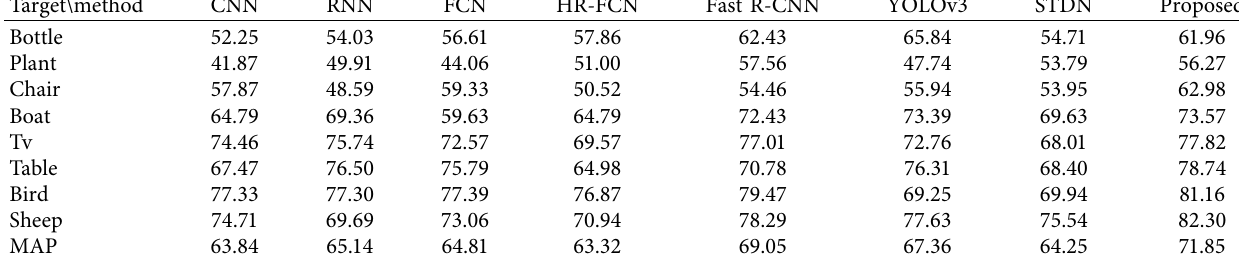
Table 4: mAP of each model on PASCAL VOC 2007.